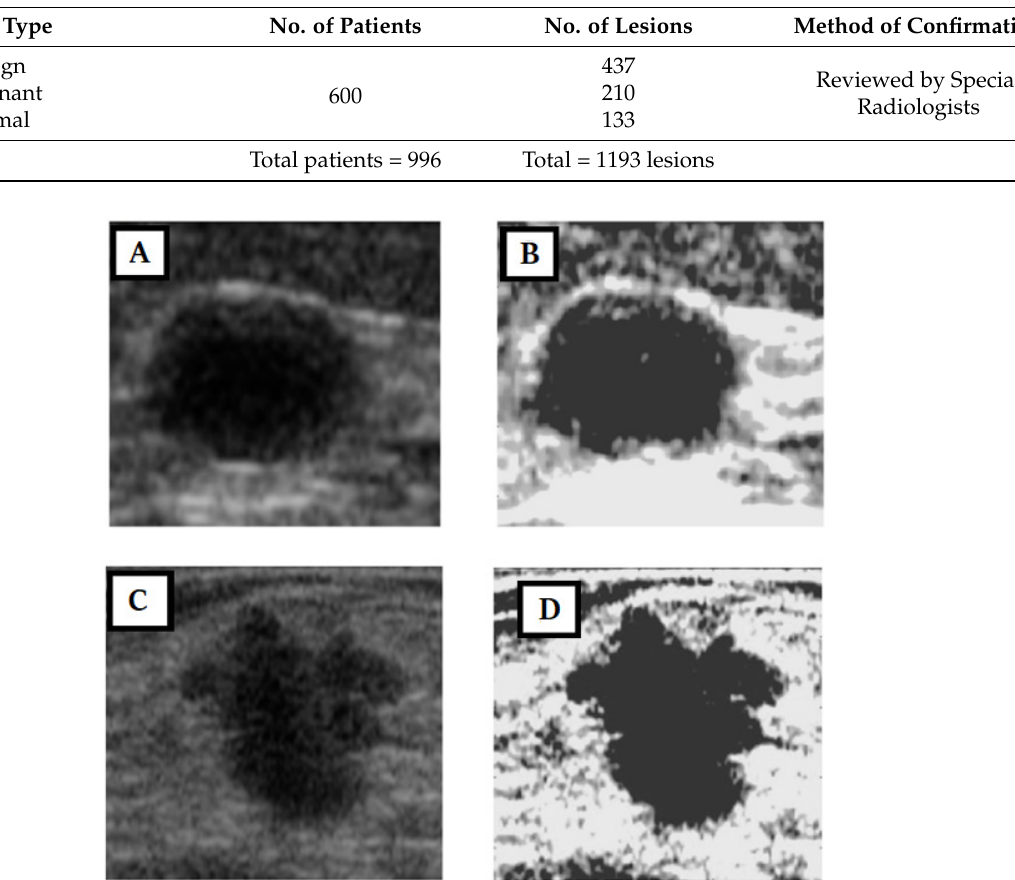
Figure 1. Example of normalization where the first row is the benign case and the second row is the malignant case. ( A , C ) US B-mode image; ( B , D ) Normalized malignant case. ( A , C ) US B-mode image; ( B , D ) Normalized image.